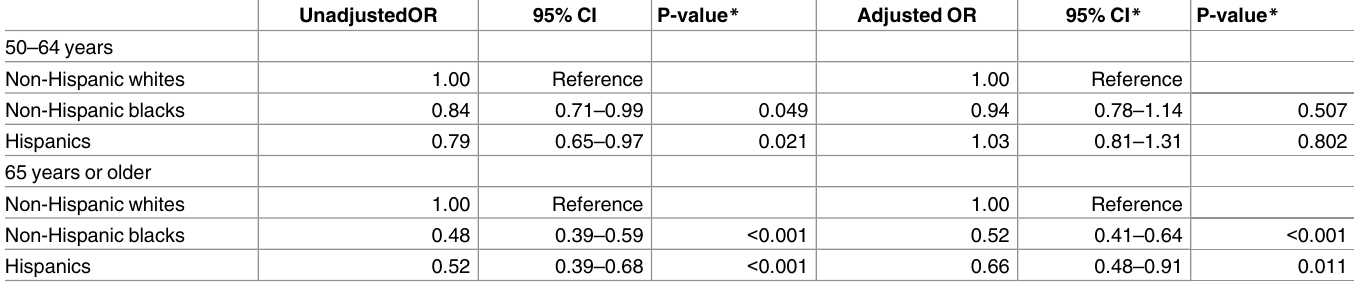
Table 2. Unadjusted and adjusted odds ratios for influenza vaccination coverageamong whites, blacks, and Hispanics aged 50–64 and (cid:21) 65 years based on logistic